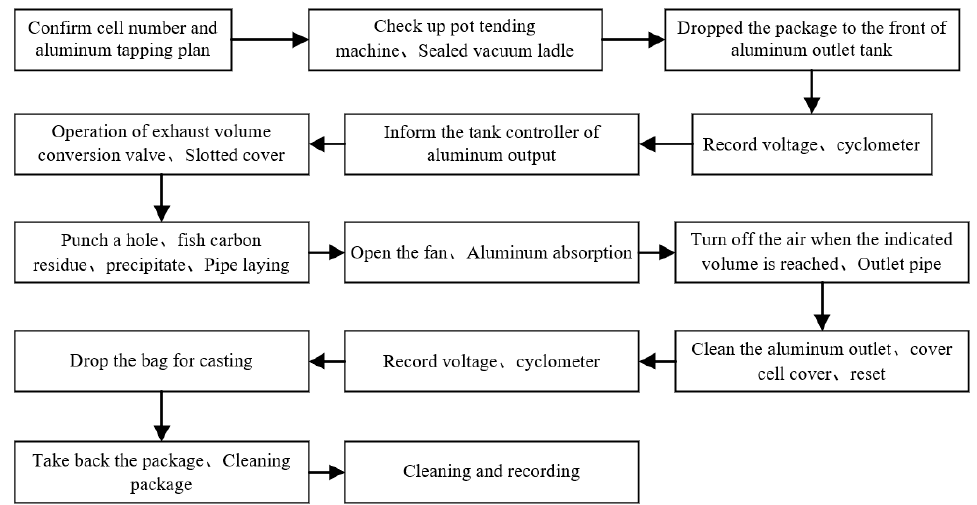
Figure 4. Flow chart of aluminum tapping.